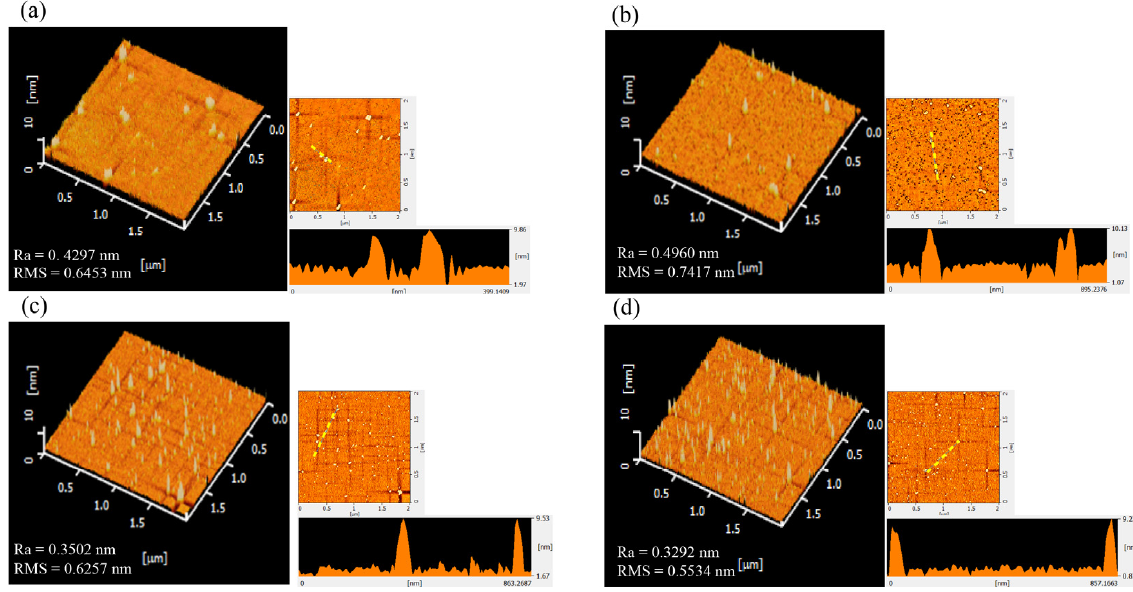
Figure 2. AFM images of silicon wafer surfaces with immobilized antibodies or aptamers. The device surfaces with immobilized antibodies ( a , b ) and aptamers ( c , d ). The 2D AFM image and line profile of height along the yellow line (the rectangular graph) are shown on the right side of each AFM image.